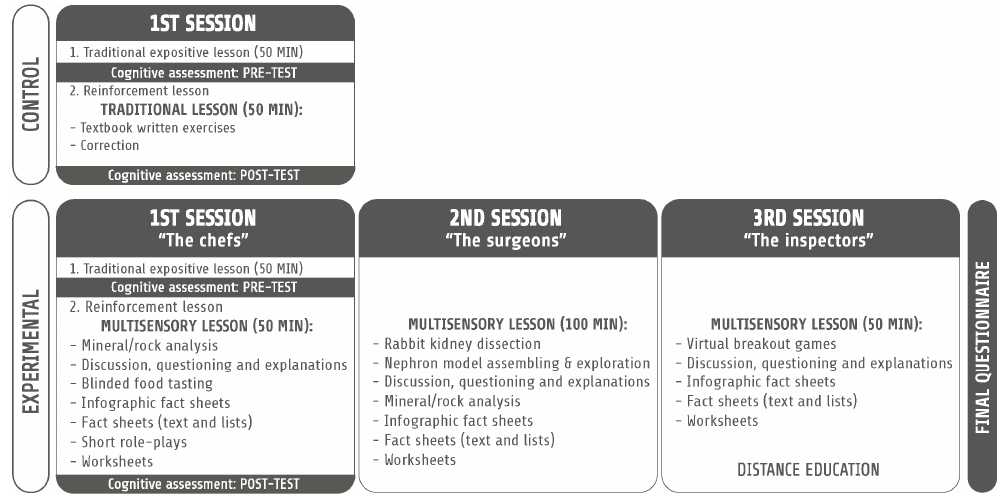
Figure 1. Workflow with the control group and the experimental group, including all strategies/activities selected for each session and the instruments of assessment applied.